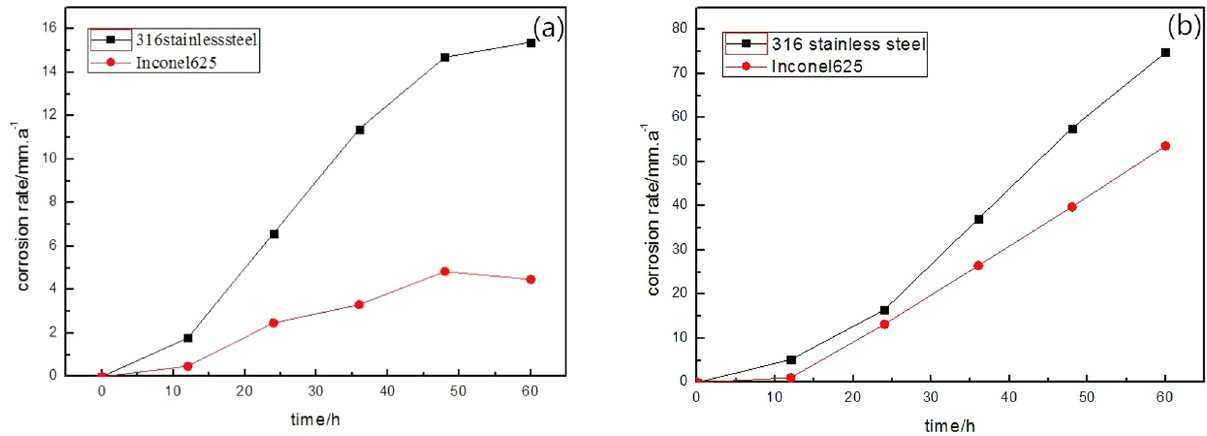
Figure 1: Corrosion weight loss curve of 316 stainless steel and Inconel 625 alloy in ternary chloride molten salt at ( a ) 700°C and ( b )